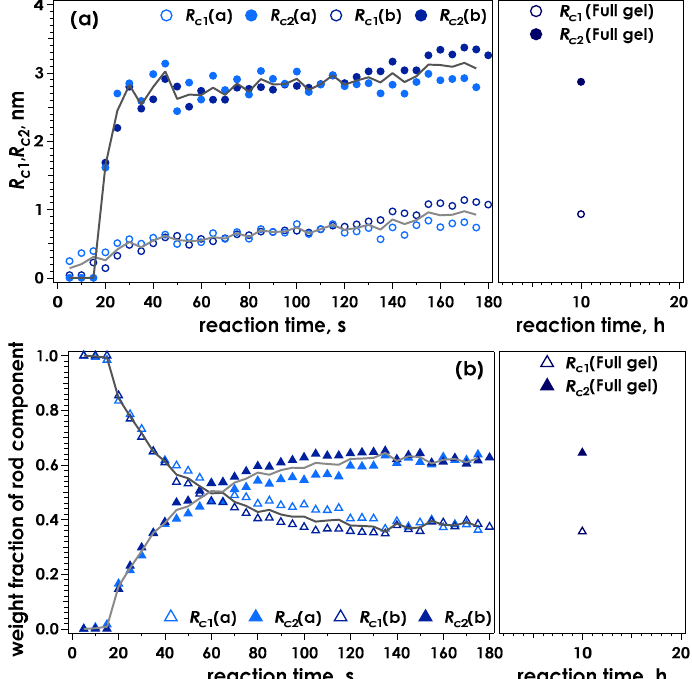
Figure 6. Time course for the calculated radii of the two rod components, R c1 and R c2 ( a ) and the corresponding weight fractions of the two components ( b ) determined by evaluation of the data presented in Figure 5 using a broken rod model. The solid lines indicate the averaged values for the two measurements.